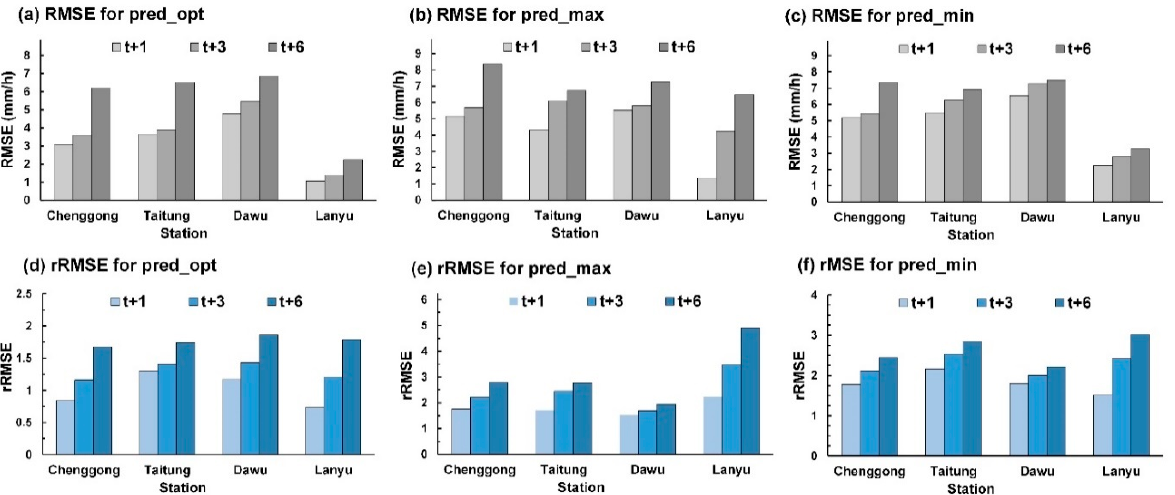
Figure 12. Average RMSE and rRMSE for test typhoons 1, 3, and 6 h ahead: ( a ) RMSE for pred_opt; ( b ) RMSE for pred_max; ( c ) RMSE for pred_min; ( d ) rRMSE for pred_opt; ( e ) rRMSE for pred_max; ( f ) rMSE for pred_min.